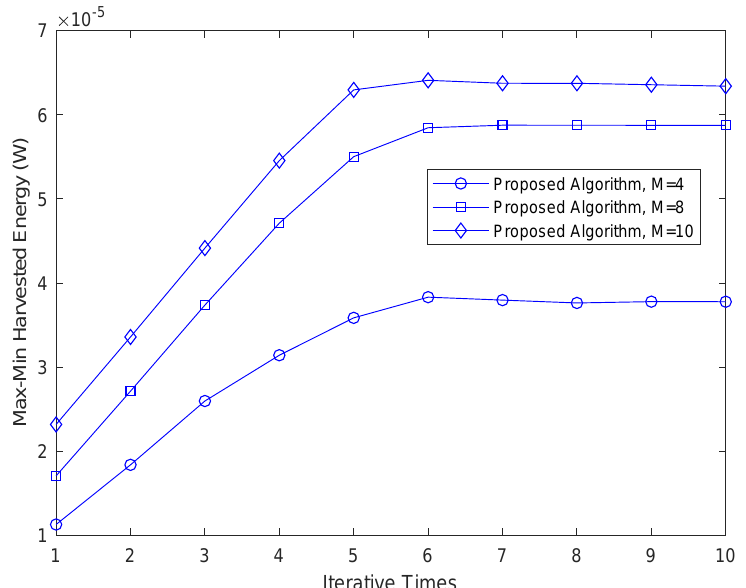
Figure 2. Convergence performance of the proposed algorithm under different numbers of reflecting elements.